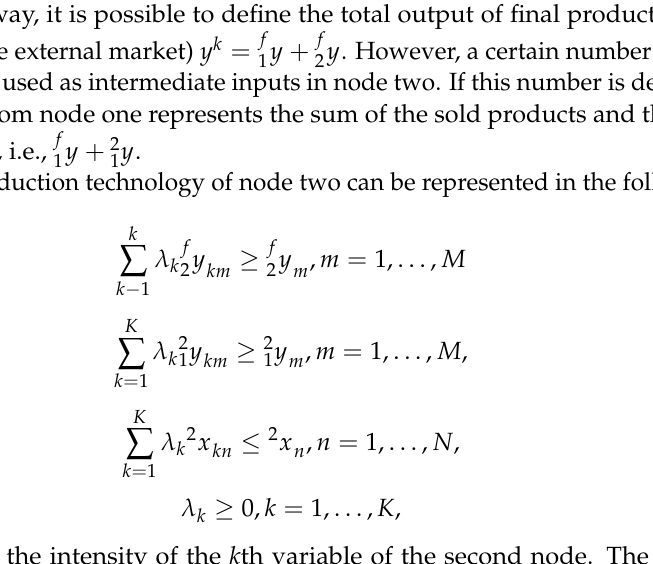
Figure 3. Two-stage process